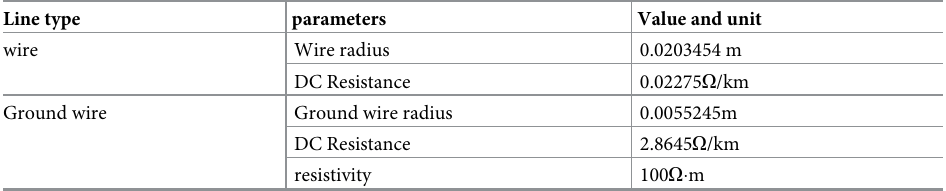
Table 3. DC transmission line